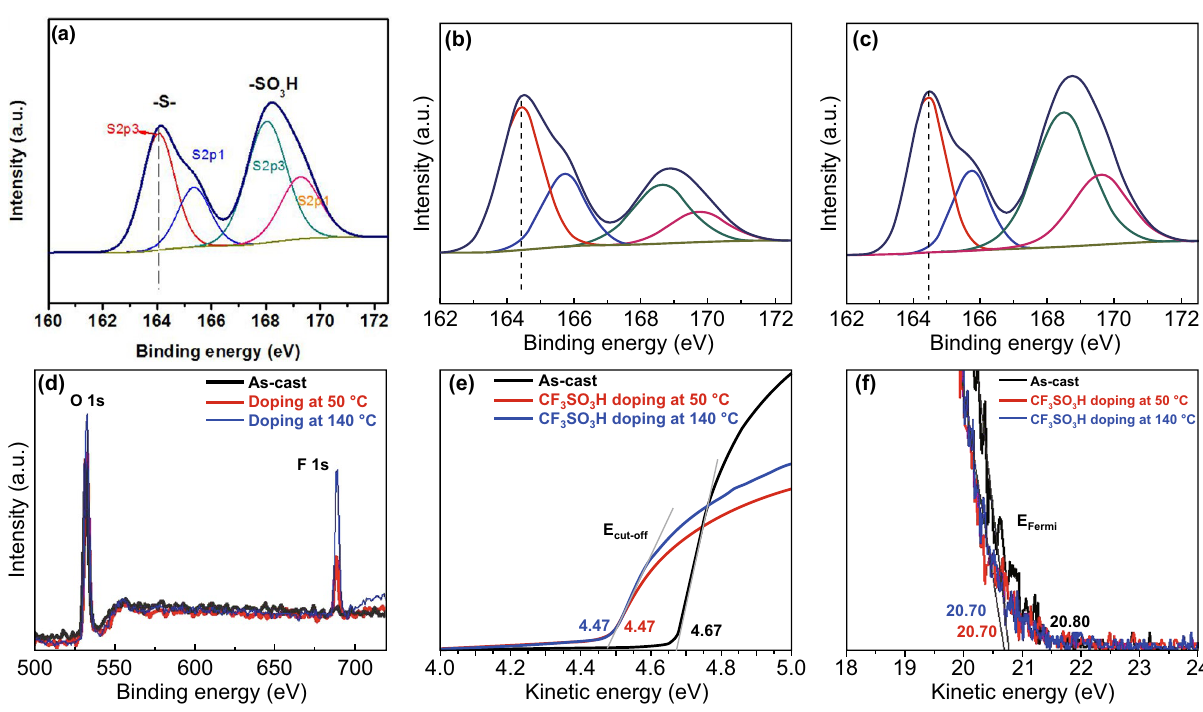
Fig. 3 Element analysis and energy levels of PEDOT:PSS films. a–c Fitted S 2p XPS of the as-cast ones for a and both ones doped at 50 °C for b and 140 °C for c . d Fluorine contents of these films. UPS of the inelastic cutoff region for e and the HOMO region of the films for